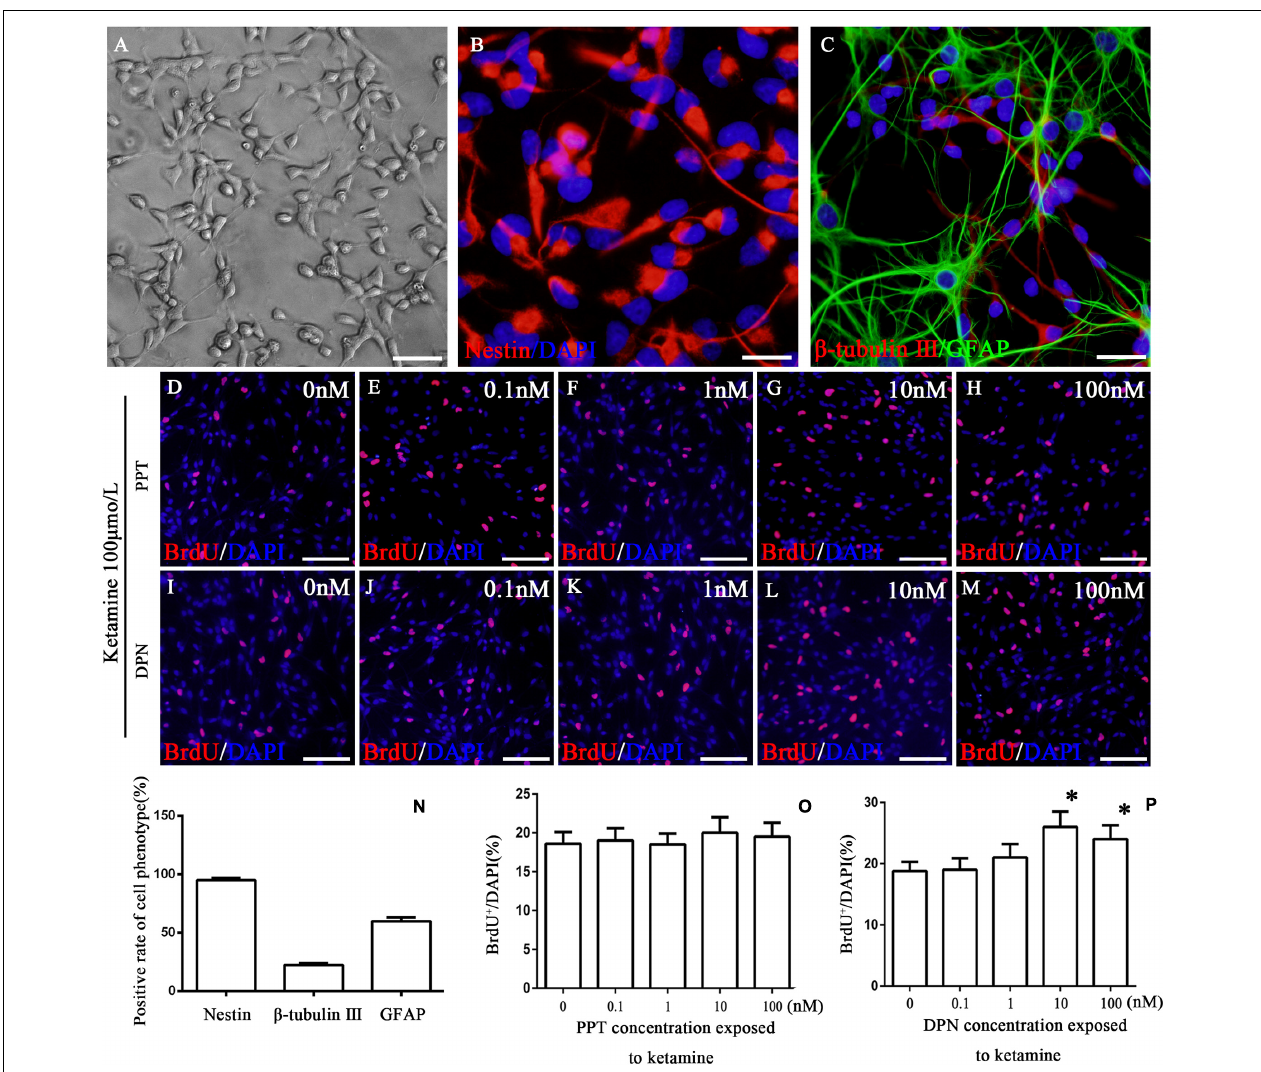
FIGURE 2 | Identification of cultured cells and the proliferation of NSPCs after co-treatment with ketamine and different concentrations of PPT/DPN. Adherent cultured neural stem cells grown 3 days and then for differentiation analysis (A) . NSPCs were assessed using an anti-nestin antibody ( B , red). Neurons were assessed using an anti- β -tubulin III antibody ( C , red) and astrocytes using an anti-GFAP antibody ( C , green). DAPI was applied for nuclear staining (blue). Scale bar = 100 µ m. (N) Rate of specific cellular phenotype to total cells. (D–H) Typical image of BrdU-positive cells (red) in different concentrations of PPT groups, respectively. Scale bar = 100 µ m. (O) Quantification of BrdU-immunoreactive cells after different treatments. There is no significant difference between groups. (I–M) The typical picture of BrdU-positive cells (red) in different concentrations of DPN groups, respectively. Scale bar = 100 µ m. (P) Quantification of BrdU-immunoreactive cells after different treatments, ∗ P < 0.01 compared with 0 nmol/L DPN group. Data were collected from three independent experiments and are presented as means ±